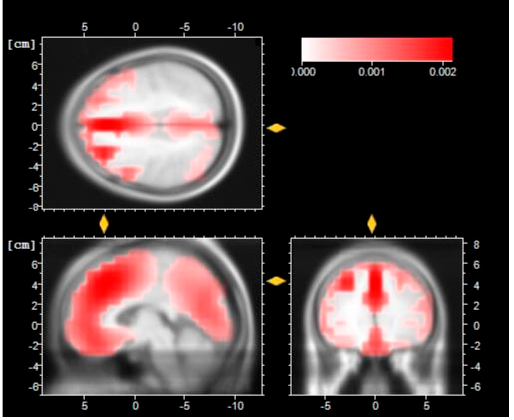
Figure 10. LORETA reconstruction of the N1 component after the Leap Motion session.